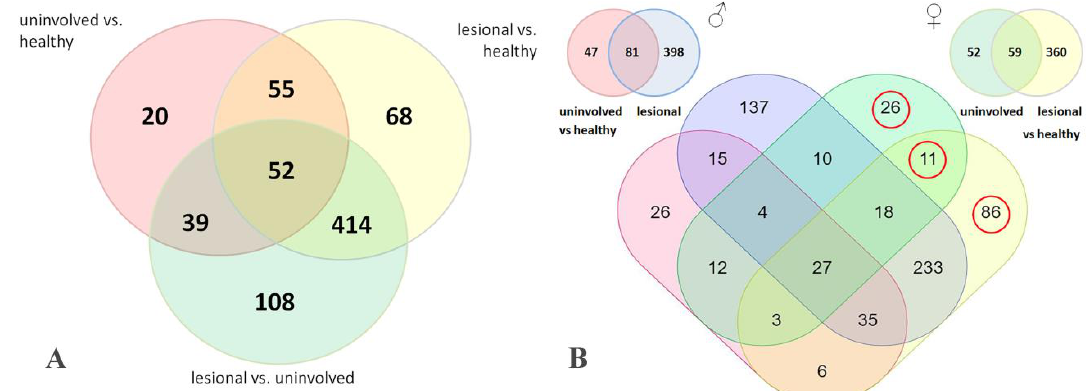
Figure 2. Venn diagram comparing DEPs in the donated skin samples as assessed by LC/MS – MS analysis. ( A ) Paired comparison of the samples obtained from lesional and uninvolved skin of the same psoriasis patients (n = 5) and skin of healthy volunteers (n = 5). ( B ) Analysis of gender-specific changes in protein expression. Samples of male (n = 3) and female (n = 2) psoriatic skin were compared to the skin of healthy volunteers (n = 5). The numbers indicated in the diagram are the numbers of DEPs in the compared groups of samples ( p < 0.05). DEPs chosen for PO analysis are encircled. The data were compared using the Mann – Whitney U test.